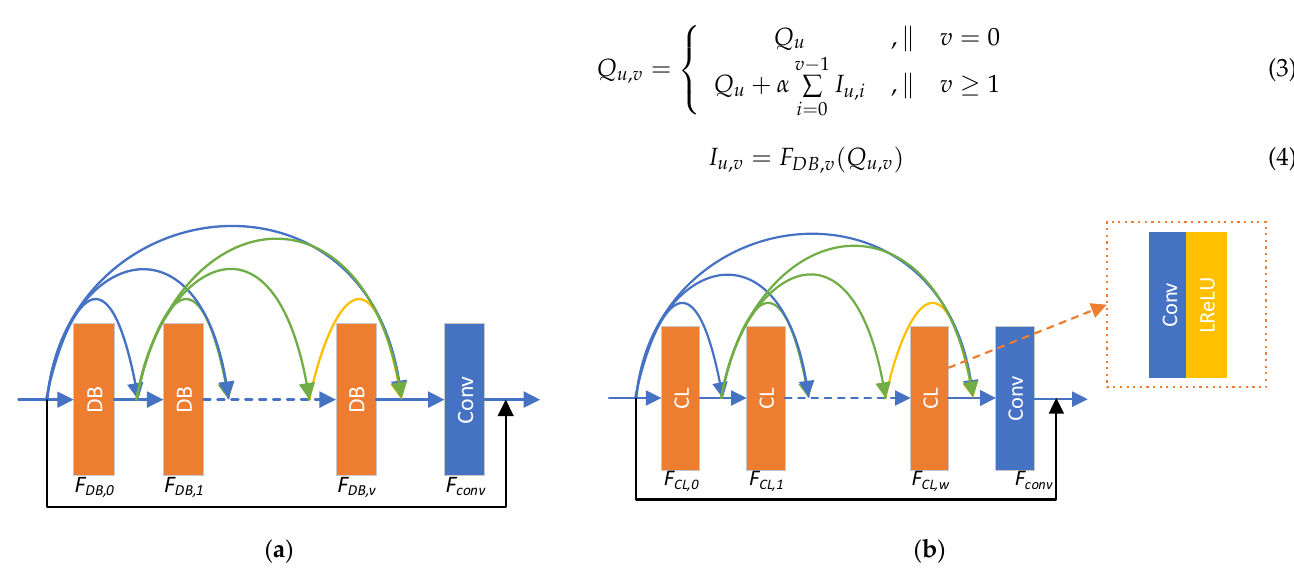
Figure 2. Internal structure of DCRDB and DB. ( a ) Internal structure of DCRDB. F DB , v represents the v -th dense block. F conv represents the convolutional layer. ( b ) Internal structure of DB. F CL , w represents the w -th CL module. The CL module consists of a convolutional layer and a LReLU layer. The arrows in the figure represent the flow of the feature map.